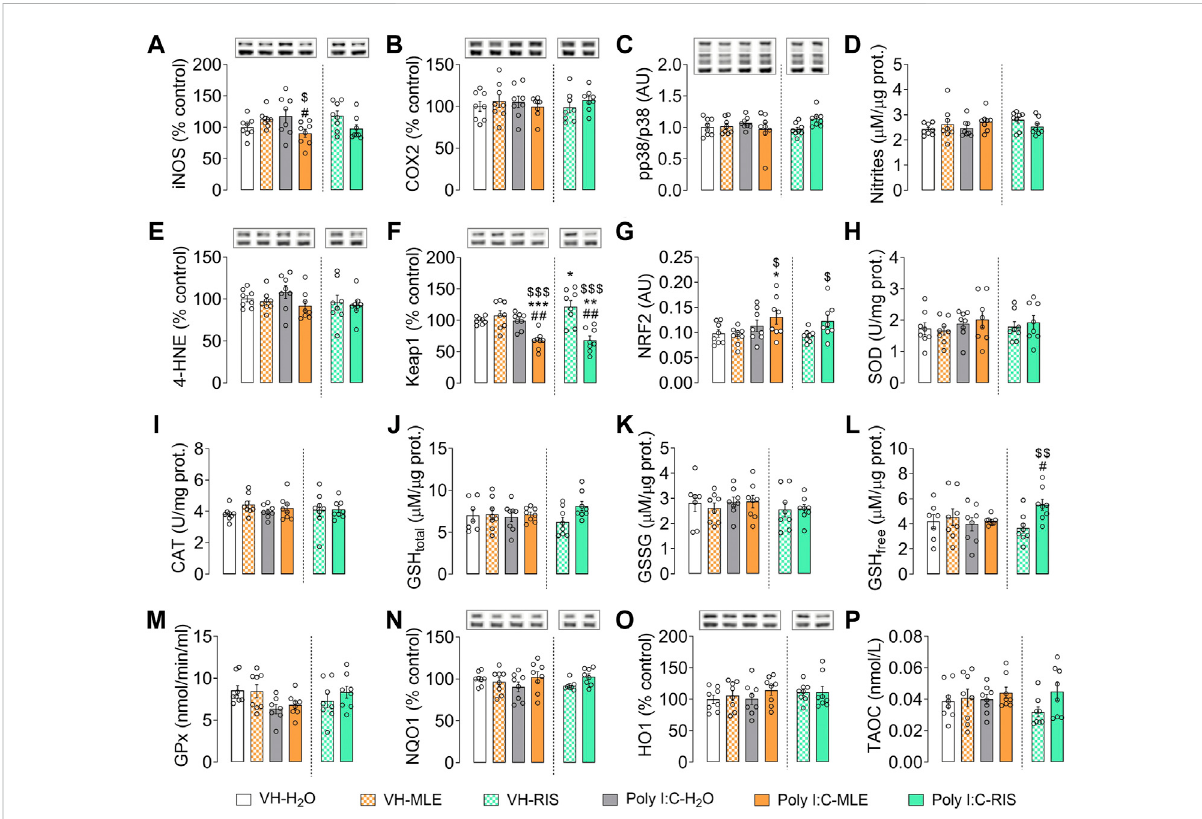
FIGURE 5 The effect of adolescent MLE or risperidone (RIS) treatment on the expression of oxidative/in fl ammatory mediators in the hippocampus. (A – C) The expressionof thein fl ammatory mediators iNOS,COX2 and p38represented as thepercentage (%)of thecontrol expression, with theexception of p38 which is represented as the ratio of phosphorylated relative to total p38 protein. (D,E) Indicators of oxidative/nitrosative damage (nitrites and 4-HNE) are expressed as their concentration (µM/µg of protein) and the % of the control expression, respectively. (F – P) The evaluation of biomarkers of compensatory antioxidant mechanisms (Keap1, NRF2, SOD, CAT, GSH/GSSG, GPx, NQO1, HO1, TAOC). Keap1, NQO1 and HO1expressionisrepresentedasthe%ofthecontrolexpression;NRF2activityisexpressedinarbitraryunits(AU);SODandCATenzymeactivitiesare expressed as U/mg of protein; the levels of total (GSH total ), oxidized (GSSG) and reduced (GSH free ) glutathione are expressed as μ M/µg of protein; Glutathione Peroxidase (GPx) is expressed in nmol/min/ml; and the Total Antioxidant Capacity (TAOC) is expressed in nmol/L. The data are representedasthemean±SEMof7-8hippocampalsamplespergroup.RepresentativebandsofiNOS,COX2,4-HNE,Keap1,NQO1andHO1(upper bands) and the β -actin loading control (lower bands) are shown above their corresponding bars in the graph. For p38 protein expression, phosphorylated and total p38 representative bands are shown relative to β -actin (lower bands). * p < 0.05, ** p < 0.01, *** p < 0.01 vs. VH-H 2 O; $ p